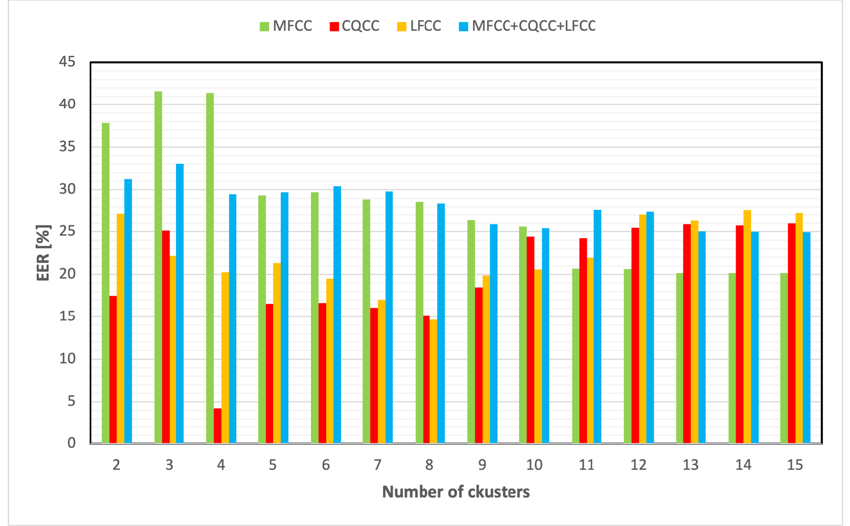
Figure 6. EER obtained by MFCC, QCC, LFCC, and concatenation together with respect to the number of clusters when using GMM on the ASVspoof 2017 version 2.0 benchmark dataset.